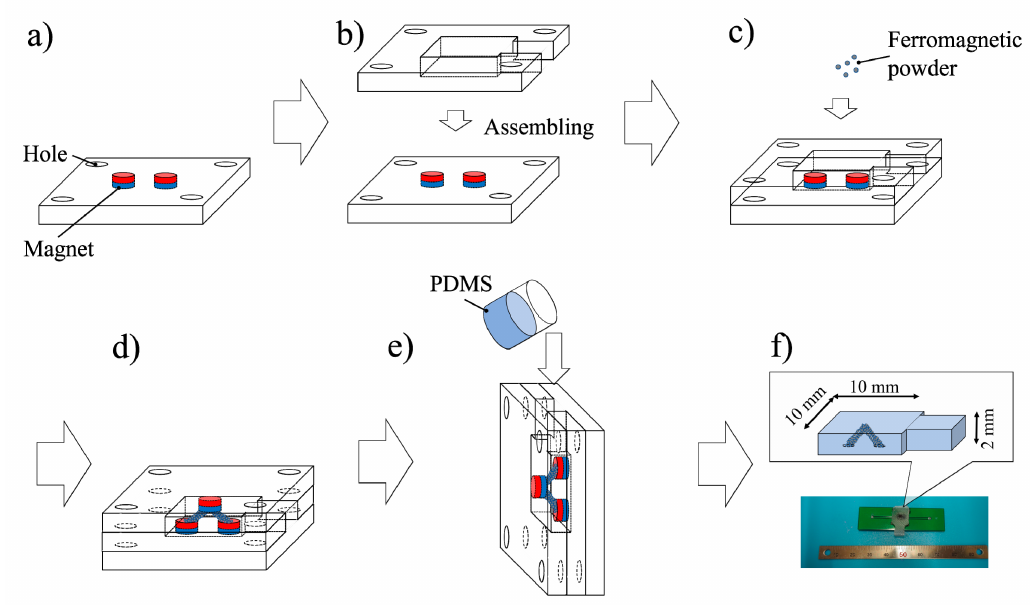
Figure 2. Fabrication process of the soft-MPS: ( a ) magnets ( ∅ 1 × 5 mm, 198 mT) are installed inside a 3D printed mold; ( b ) a spacer (thickness: 2 mm) is set for pouring the polydimethylsiloxane (PDMS) solution; ( c ) ferromagnetic powder (200 mesh) is added into the mold with the magnets; ( d ) the top lid is attached to bridge the ferromagnetic powder; ( e ) PDMS is poured into the mold; ( f ) the soft-MPS (area: 10 mm 2 , thickness: 2 mm) is obtained and the sensor is fixed on a printed circuit board with a conductive